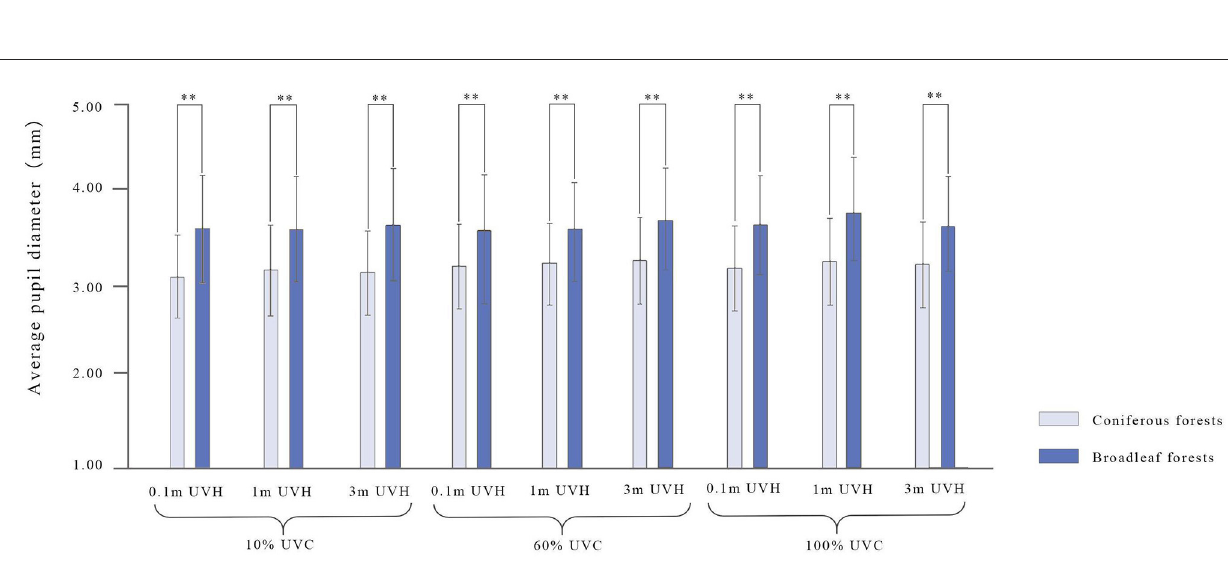
p < 0.01, η p2 = 0.10], specifically, viewing 0.1 m UVH has